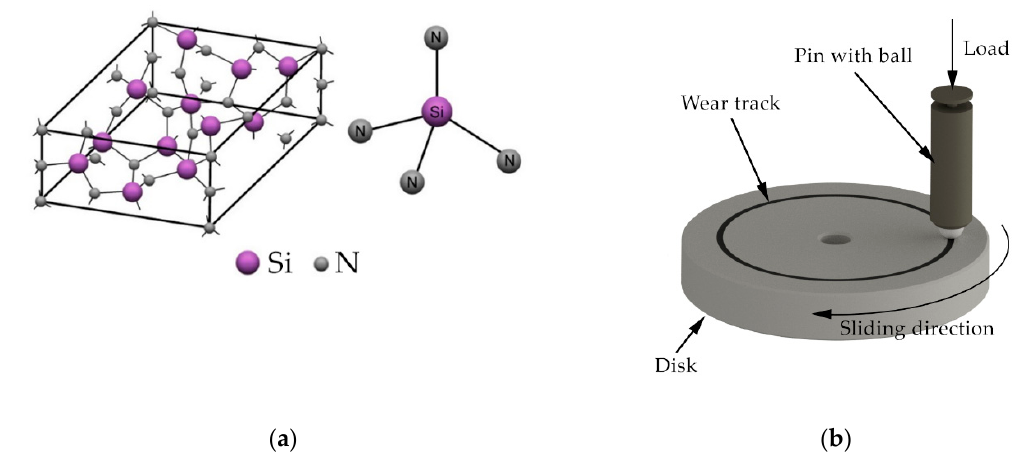
Figure 4. ( a ) Hexagonal β -Si 3 N 4 structure; ( b ) principle of measurement by the ball-on-disc method